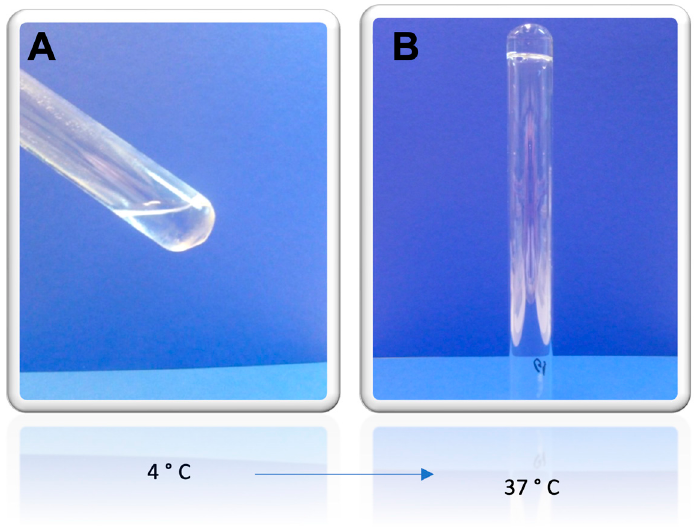
Figure 5. Macroscopic appearance of the thermoreversible Pluronic ® F127 hydrogel at ( A ) 4 °C, in liquid state, and ( B ) 37 °C, gelled.